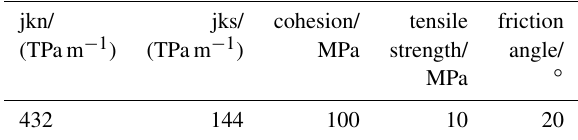
Table 11. Grain-scale contact parameters for stone.